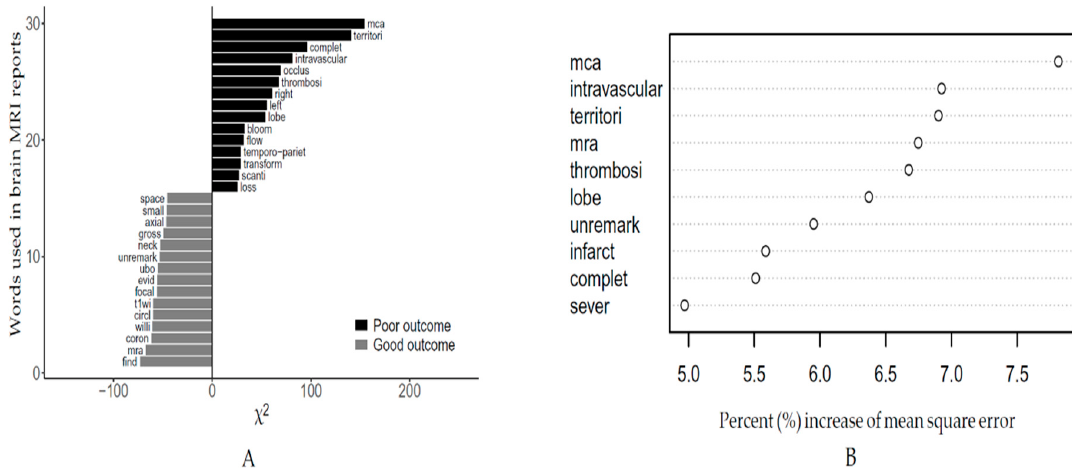
Figure 2. Result of keyness plot showing the relative frequency of word tokens between the good and poor outcome groups ( A ). Variable importance plot for the stemming words in the random forest algorithm (mca, middle cerebral artery) ( B ).